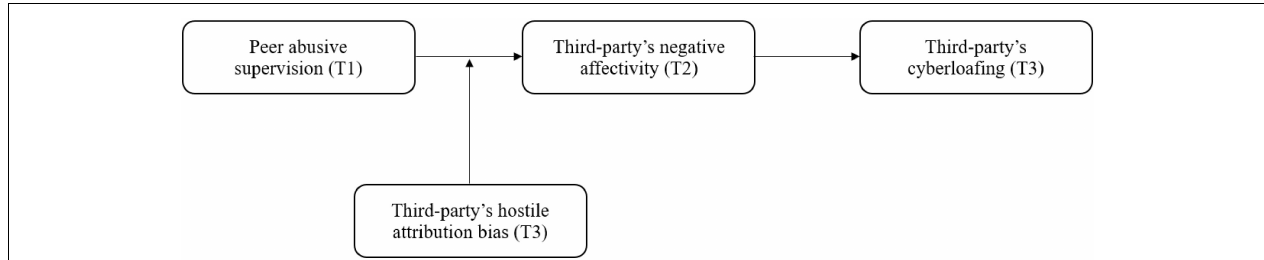
FIGURE 1 | Theoretical framework of current